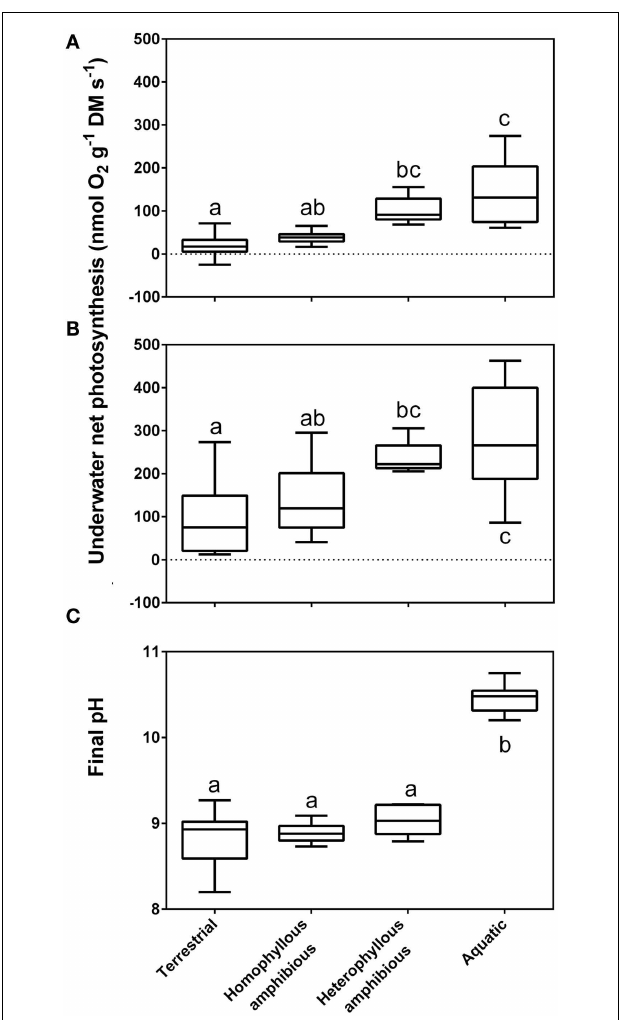
FIGURE 2 | Rates of underwater net photosynthesis (nmol O 2 g − 1 DM s − 1 ) in ambient [(A), 90–400 µ mol CO 2 L − 1 ] and CO 2 enriched water [(B), 800 µ mol CO 2 L − 1 ] and final pH from a pH drift experiment; Section “pH DriftApproach to Establish CO 2 Compensation Points” (C) in four groups of life forms defined in Sculthorpe (1967) .The box whisker plot indicates the range of the observations (bars), 50% of the observations (boxes) and the median (horizontal line).The amount of free CO 2 present at median final pH of the four groups was 6.20, 6.00, 4.80, and 0.04 µ mol L − 1 , respectively. Leaves of aquatic plants species ( n = 10), heterophyllous amphibious plants ( n = 5), homophyllous amphibious plants ( n = 7) were all produced under water while leaves of terrestrial plant species were formed in air ( n = 12). Letters indicate significant differences ( P < 0.05);Tukey test. Data from Sand-Jensen et al. (1992), with measurements taken at